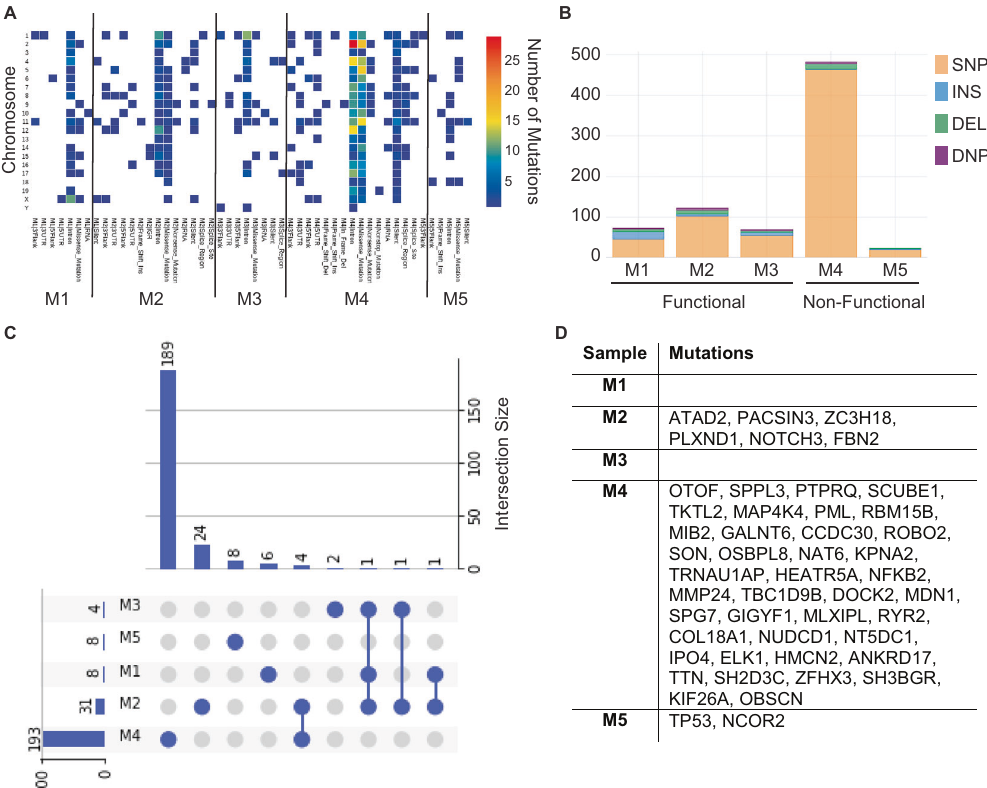
Fig. 4 INS-p25OE tumors possess mutations found in human PanNETs. A Heat map of number of total mutations in each INS-p25OE PanNET by classi fi cation per chromosome. B Type of mutations present in each INS-p25OE PanNET. (SNP single nucleotide polymorphism, INS insertion, DEL deletion, DNP double nucleotide polymorphism). C Waterfall plot of overlapping exonal mutations among INS-p25OE PanNETs. D Table of genes in which mutations in INS-p25OE PanNETs overlap with mutations in human